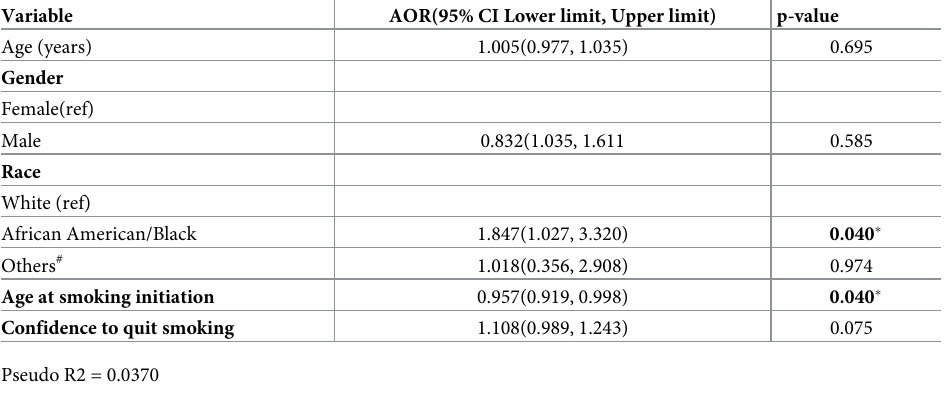
Table 5. Predictors of program satisfaction among the